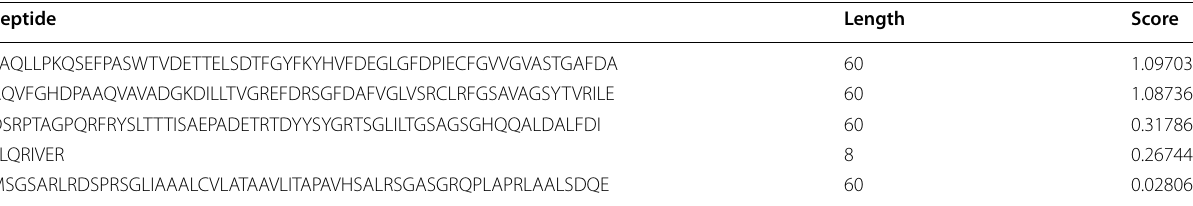
Table 3 Sequence and threshold values of MHC ligands of NHP1 protein using NetCTL server